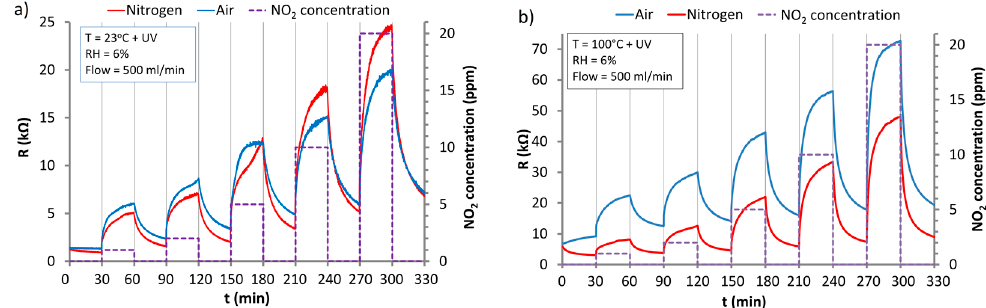
Figure 9. The response of the ZnO sensor to the action of NO 2 under UV irradiation in the atmosphere of synthetic air and nitrogen at: ( a ) RT; ( b ) 100 °C.